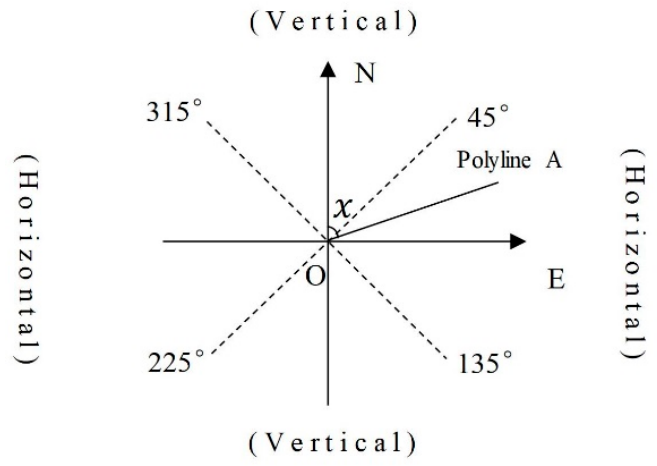
Figure 7. The range of vertical and horizontal (N: north, E: east).